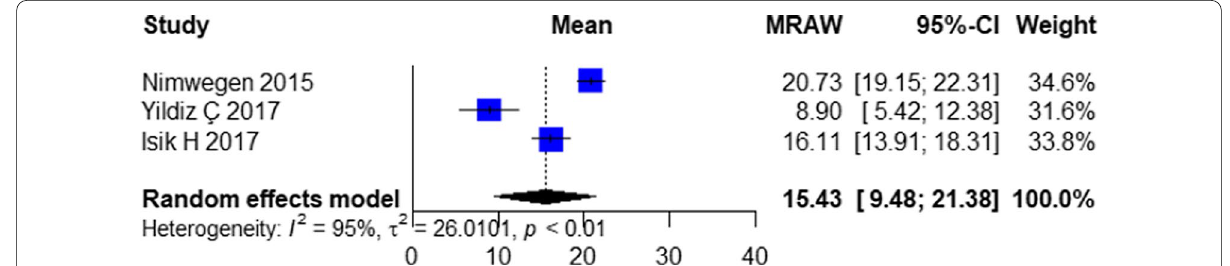
Fig. 4 Meta‑analysis of the female sexual function index (FSFI) in women with Sjogren’s syndrome